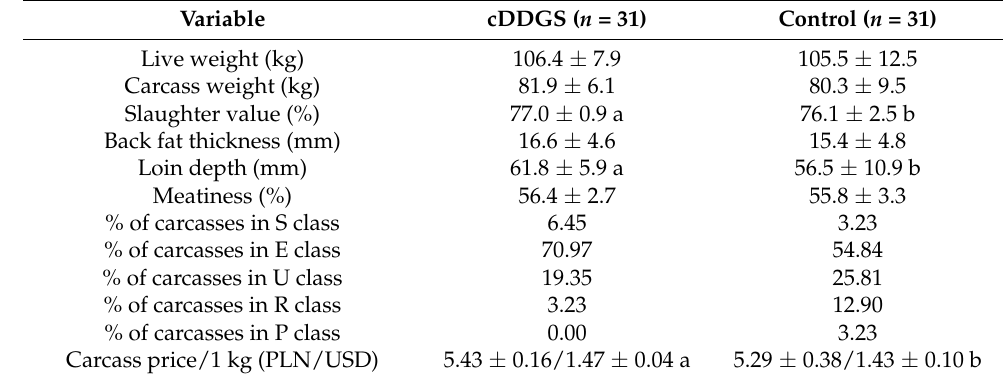
Table 5. Summary of the slaughter values, SEUROP system carcass classifications, and mean prices of pig carcasses (means ±